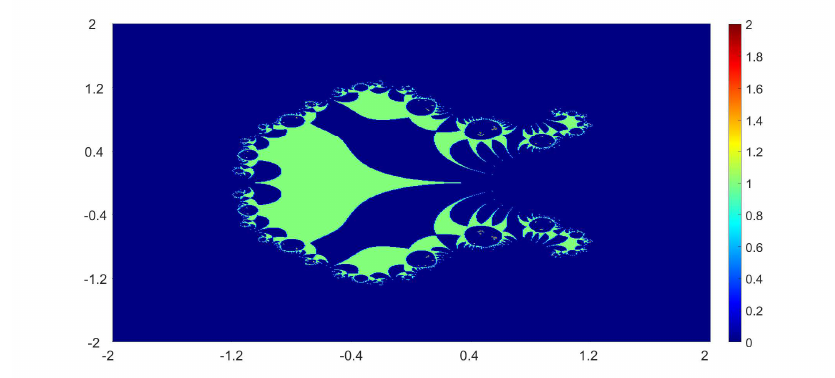
Figure 13. Example